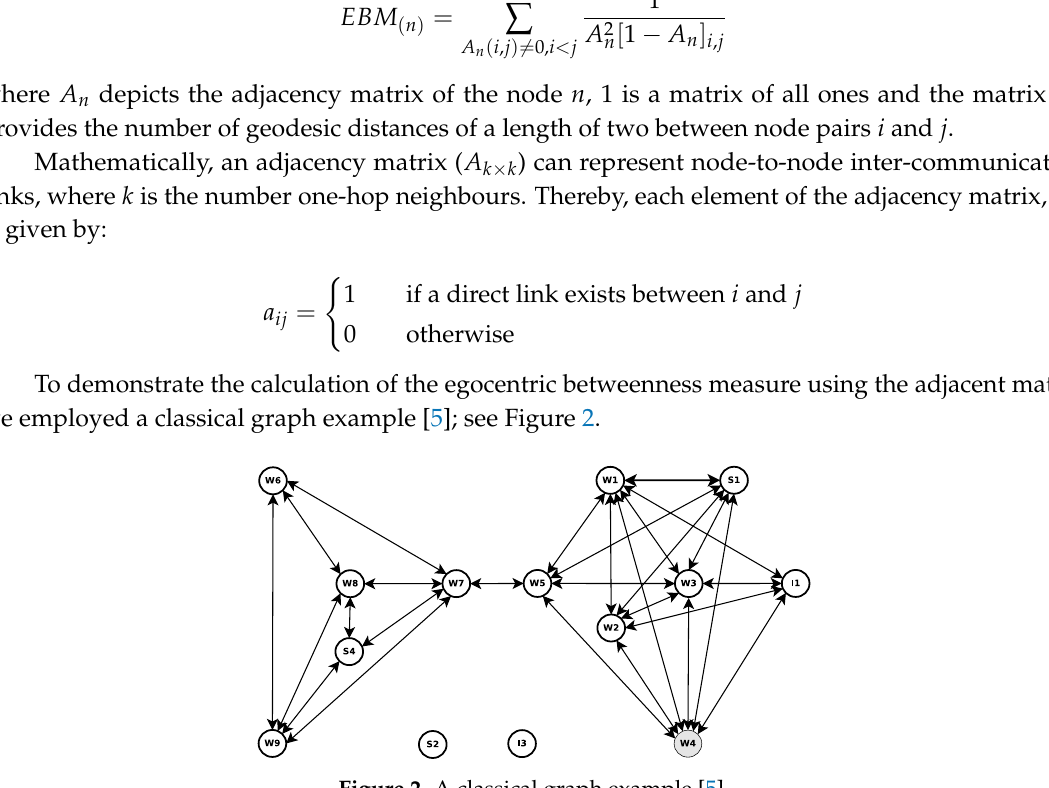
Figure 2. A classical graph example